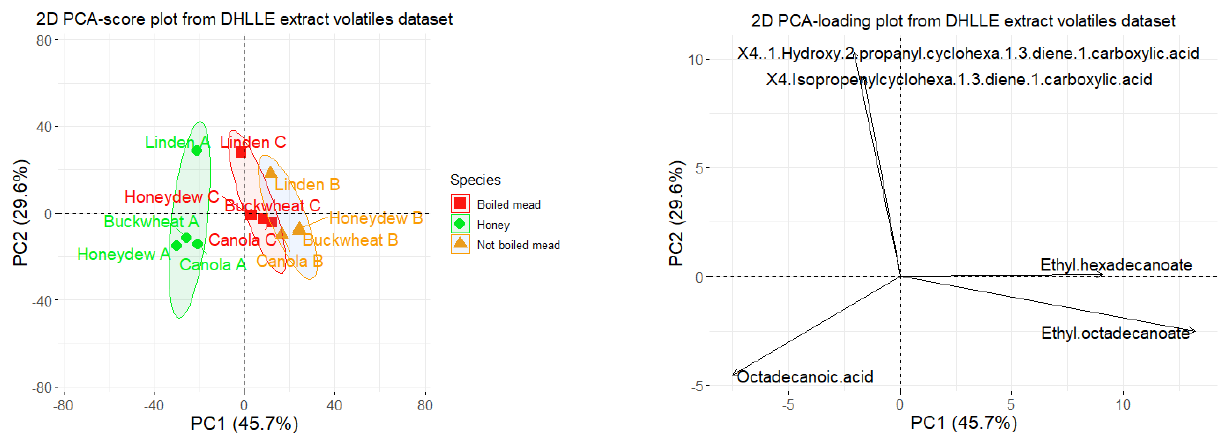
Figure 5. Principal component analysis (PCA) scores ( left ) and loadings ( right , only first five variables with the highest contributions are shown) plots based on the DHLLE volatiles extract dataset.